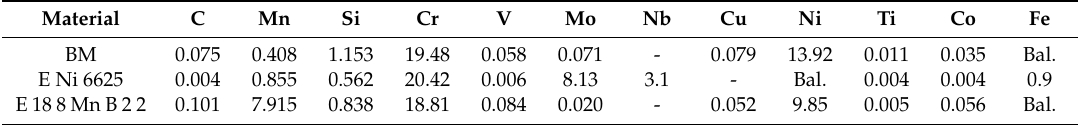
Figure 2. Fronius Trans Pulse Synergic 5000 CMT. Table 1. Chemical composition of used materials (wt%). Bal.—balance.